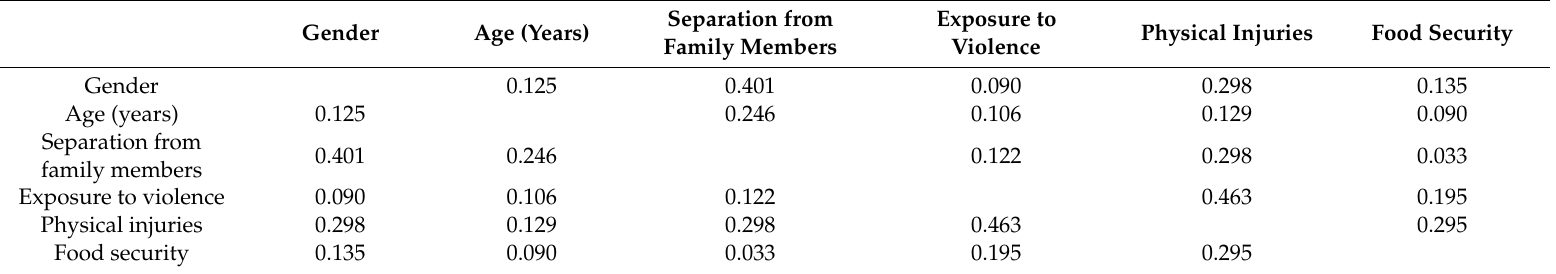
Table A3. Testing for multicollinearity among the independent variables significant at 0.25 in the univariate analysis examining the factors associated with